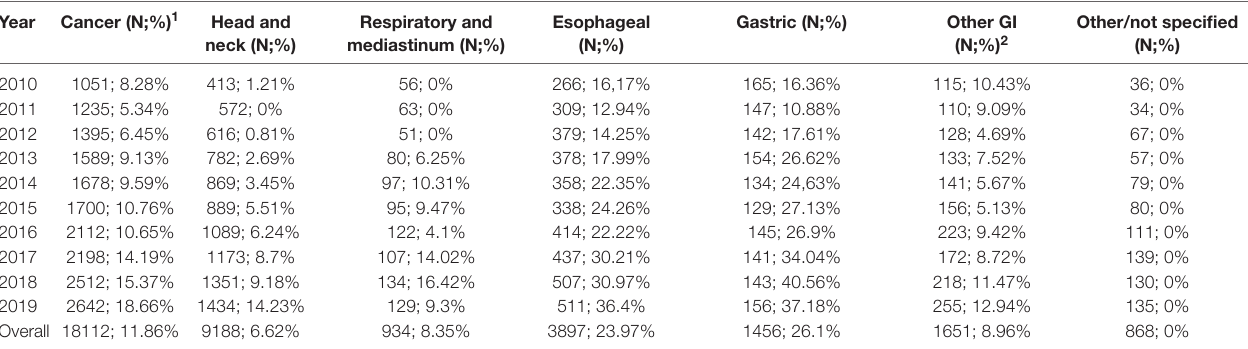
FIGURE 4 | Esophageal cancer patients with gastrostomy. (A) The percentage of all esophageal cancer patients with gastrostomies in Poland and (B) the percentage of esophageal cancer patients with gastrostomies on HEN. TABLE 3 | Patients with cancer (primary or secondary diagnosis) with percutaneous endoscopic gastrostomies (PEGs) on home enteral nutrition